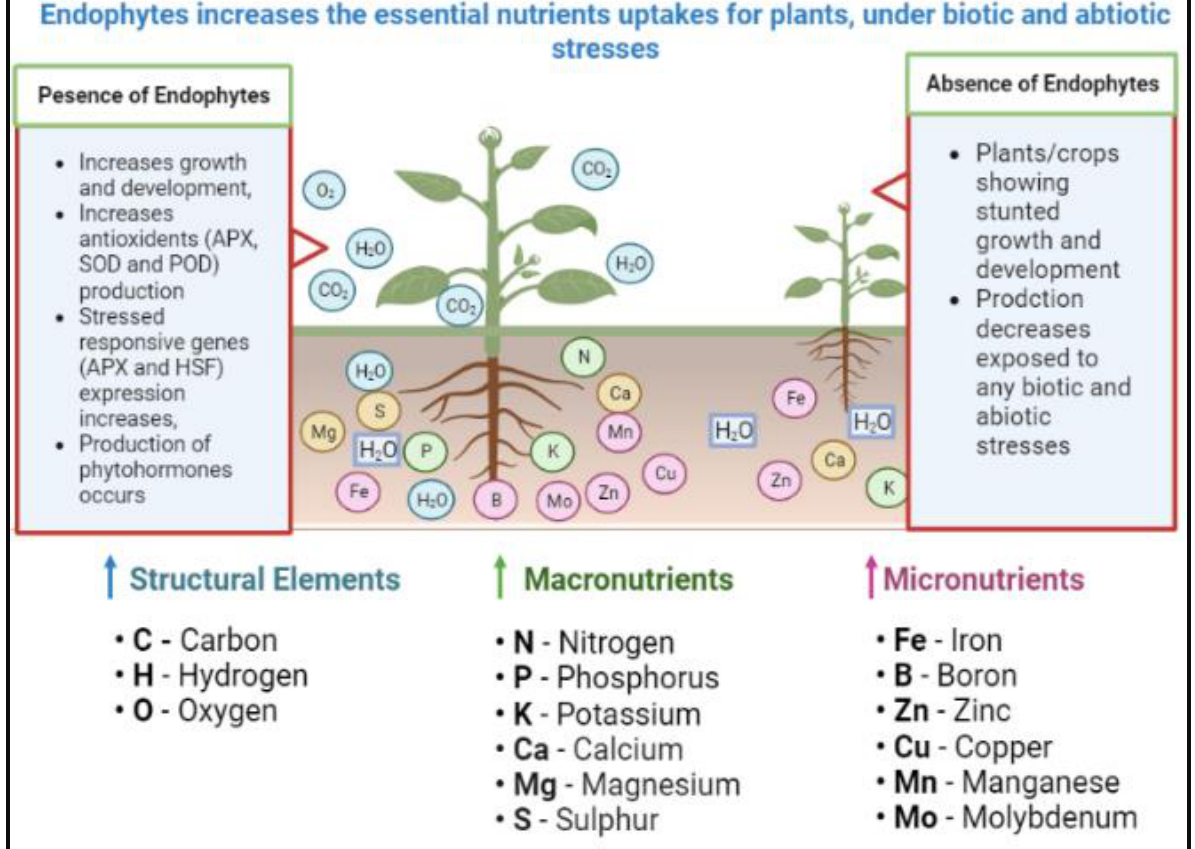
Figure 5. Comparison of different macro and micro heavy metals contaminated soil and with-out plants-endophytes inoculations. Plants inoculated with endophytes have higher growth and comparatively increases the absorption of macro-micro-nutrients than the un-inoculated plants/crops, under heavy metal stressed conditions.